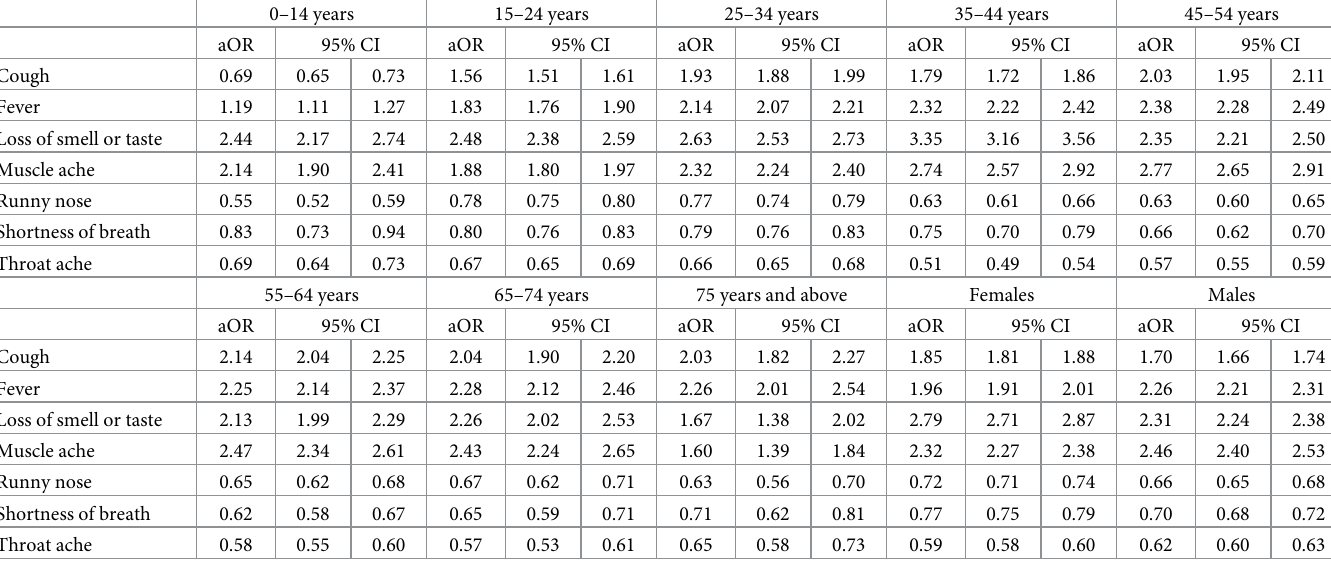
Table 4. Odds ratios and 95% confidence intervals per symptom in full multivariable logistic regression models per age group and gender, from June 2020 through August 2021, Amsterdam region, the